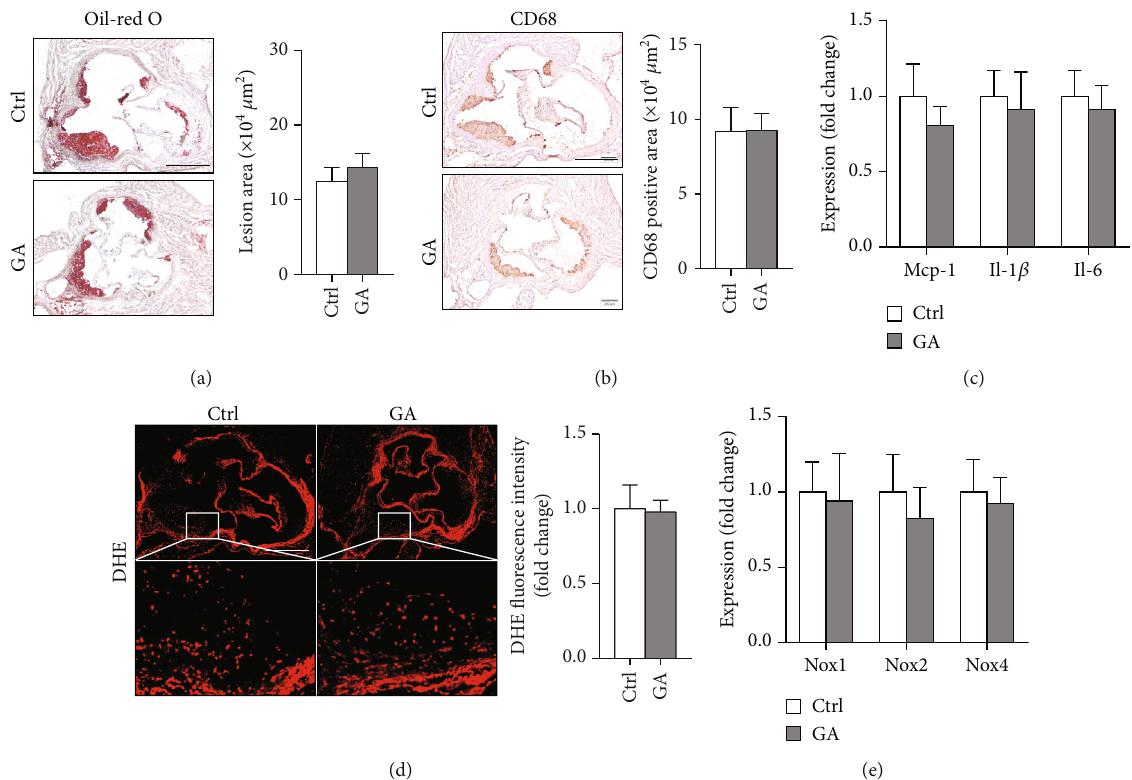
Figure 5: E ff ect of low-dose GA administration on diet-induced atherosclerosis in the Apoe KO mice. (a) Representative Oil-red O staining images of aortic root section and quantitation of aortic atherosclerotic plaque areas. (b) Representative CD68 immunochemical staining images of aortic root section and quantitation of CD68 positive macrophages in fi ltrated into the atherosclerotic plaques. (c) Quantitative real-time PCR analysis of macrophage in fl ammation-related gene expression in the aorta. (d) Representative DHE staining images of aortic root section and quantitation of DHE fl uorescence intensity. The bar represents 500 μ m. (e) Quantitative real-time PCR analysis of Noxs gene expression in the aorta. n = 6 -8 per